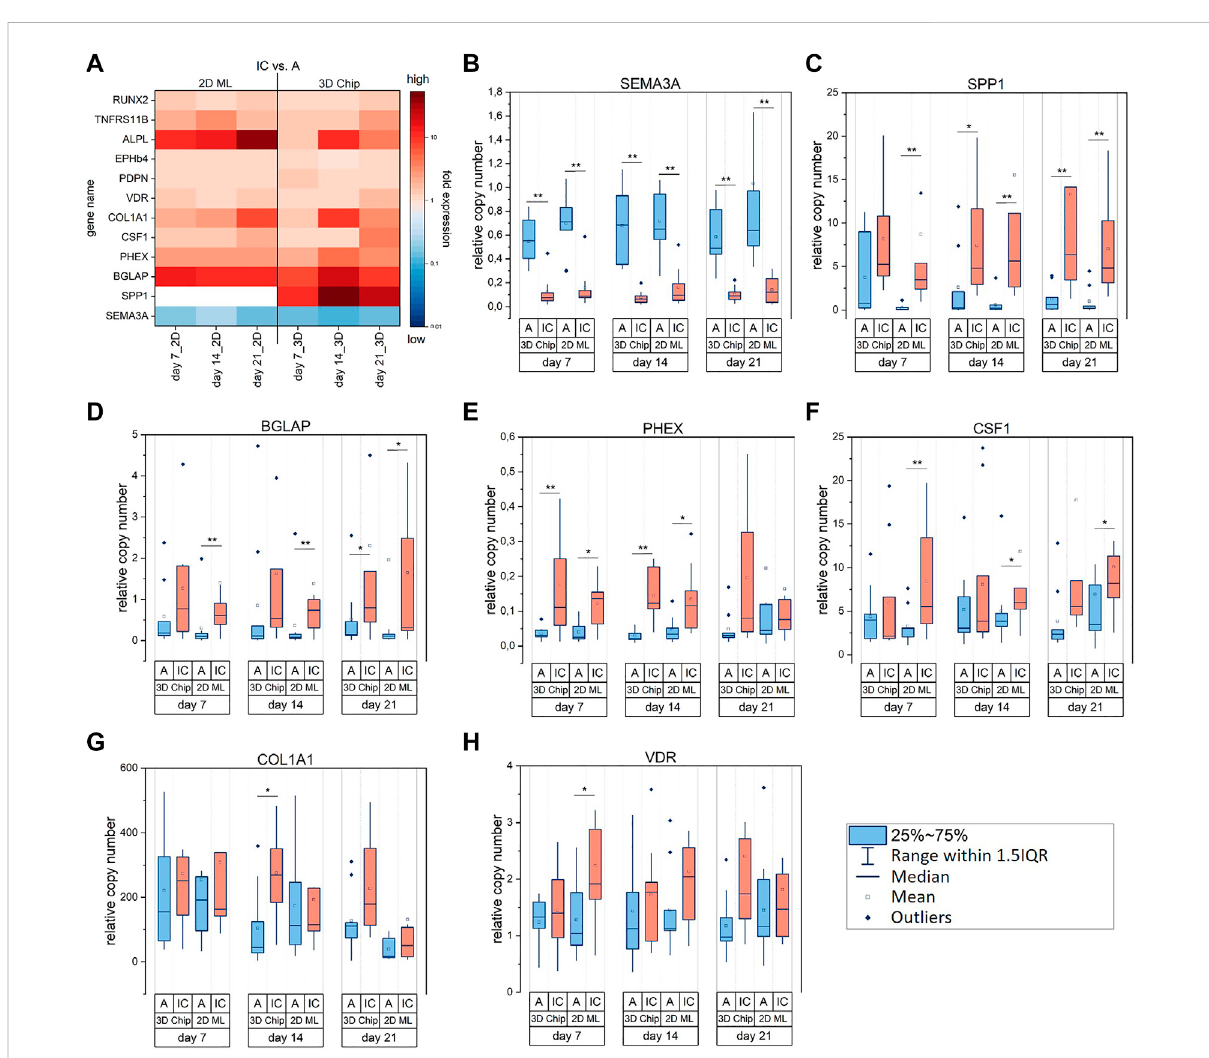
FIGURE 4 Relative gene expression of biomarkers differently expressed between osteoblasts derived from alveolar bone (hOB-A, blue) and iliac crest (hOB-IC, red) of the same donor. hOB were cultured in 3D-microchip and 2D ML culture under osteogenic conditions. (A) The transcriptional differencebetweenhOB-IC andhOB-Aisgivenbythefoldexpression,i.e.,hOB-IC/hOB-Aratioofnormalizedcopynumbersanddescribesthefold expression of biomarkers in hOB-IC versus hOB-A. A ratio of 1 means no difference, > 1 higher expression, and < 1 lower expression. (B – H) Relative transcript levels in each cell type for biomarkers which were signi fi cantly different between hOB-IC and hOB-A. The copy numbers of the target genes at days 7, 14 and 21 were normalized to copy numbers of the reference gene HPRT1 (hypoxanthine phosphoribosyl-transferase 1). The relative copy numbers of each experimental group, i.e. cell type, were compared and tested for statistically signi fi cant difference. * p < 0.05 ** p < 0.01 for comparison of hOB-A with hOB-IC; Wilcoxon signed-rank test, n = 9 donors. SEMA3A (semaphorin-3A), SPP1 (osteopontin), BGLAP (osteocalcin), PHEX (phosphate regulating endopeptidase, X-linked), CSF1 (colony stimulating factor 1), COL1A1 (collagen type 1 alpha 1 chain) and VDR (vitamin D receptor). White areas in the heatmap (A) indicate out of range values for SPP1 in 2D ML with values higher than 160-fold